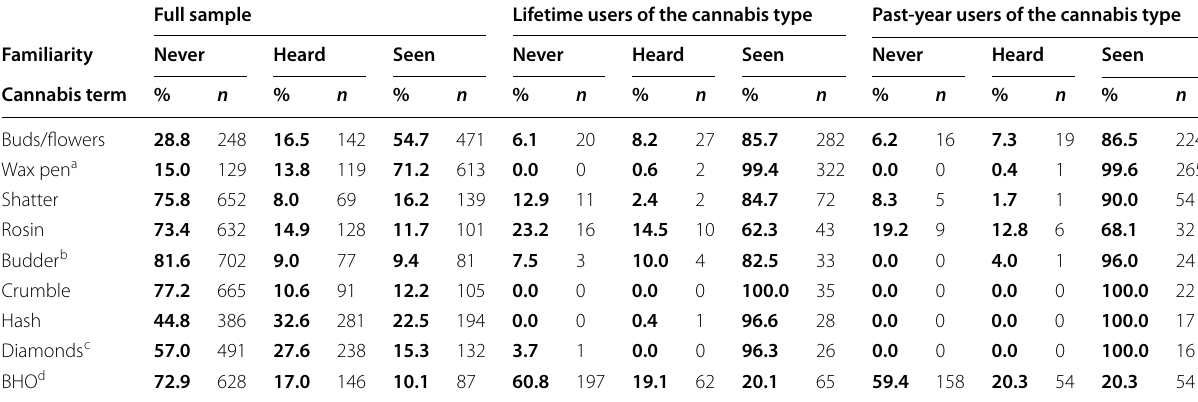
Table 2 Cannabis product familiarity in the full sample ( N of each specific type of